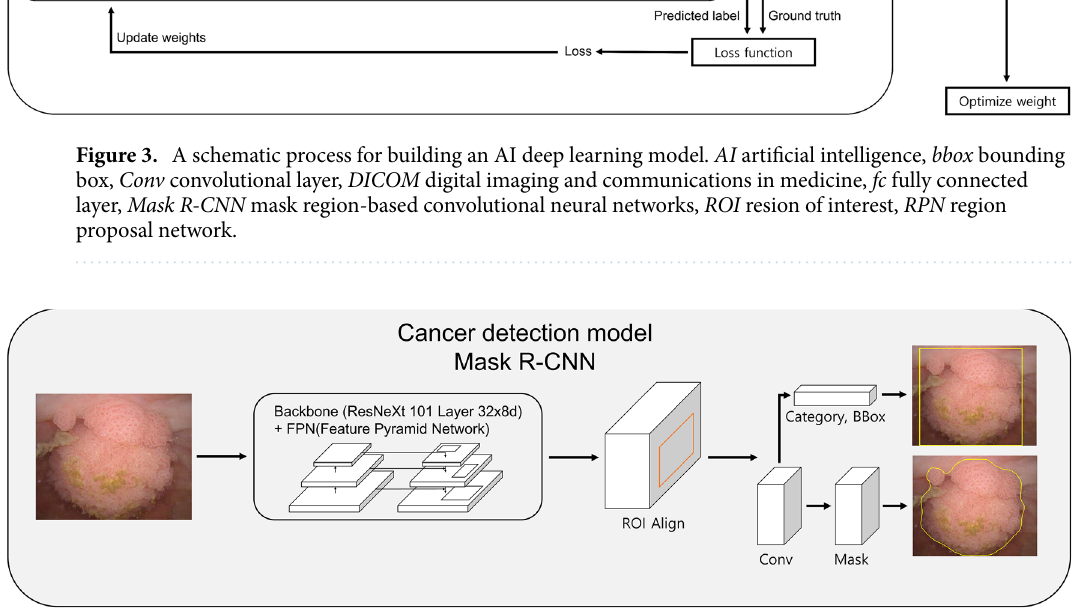
Figure 4. A practical example of the Mask R-CNN algorithm of an AI deep learning model. AI artificial intelligence, bbox bounding box, Conv convolutional layer, Mask R-CNN mask region-based convolutional neural networks, ROI region of